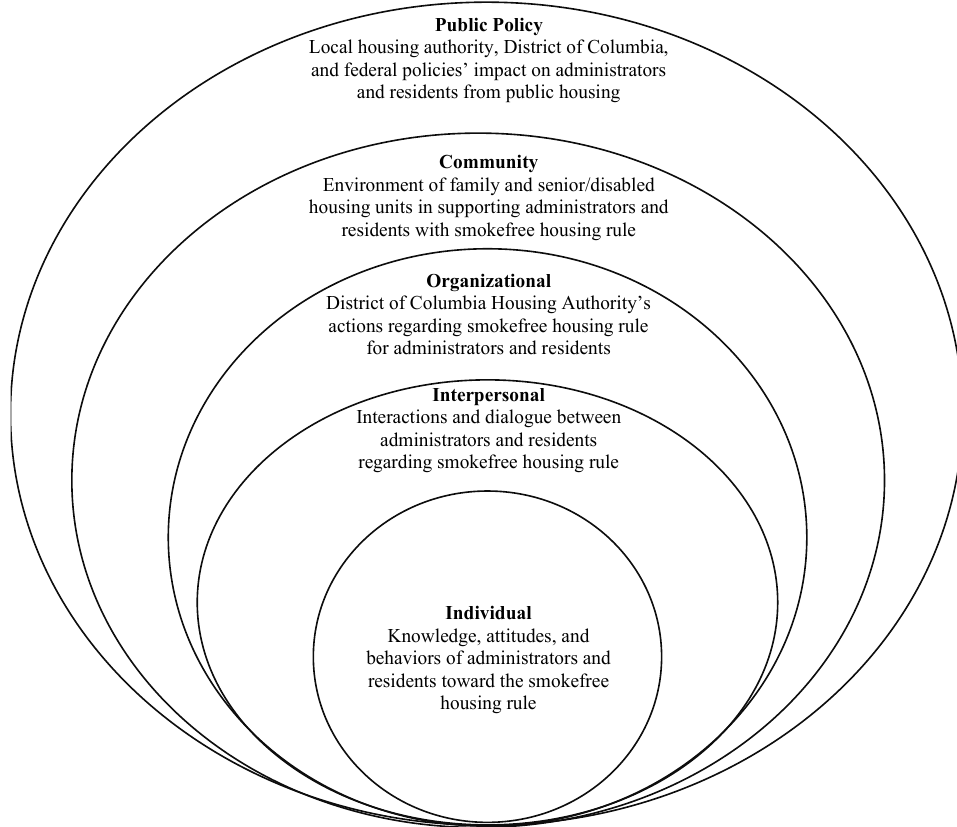
Figure 1. Illustration of the socio-ecological framework specific to the current study.